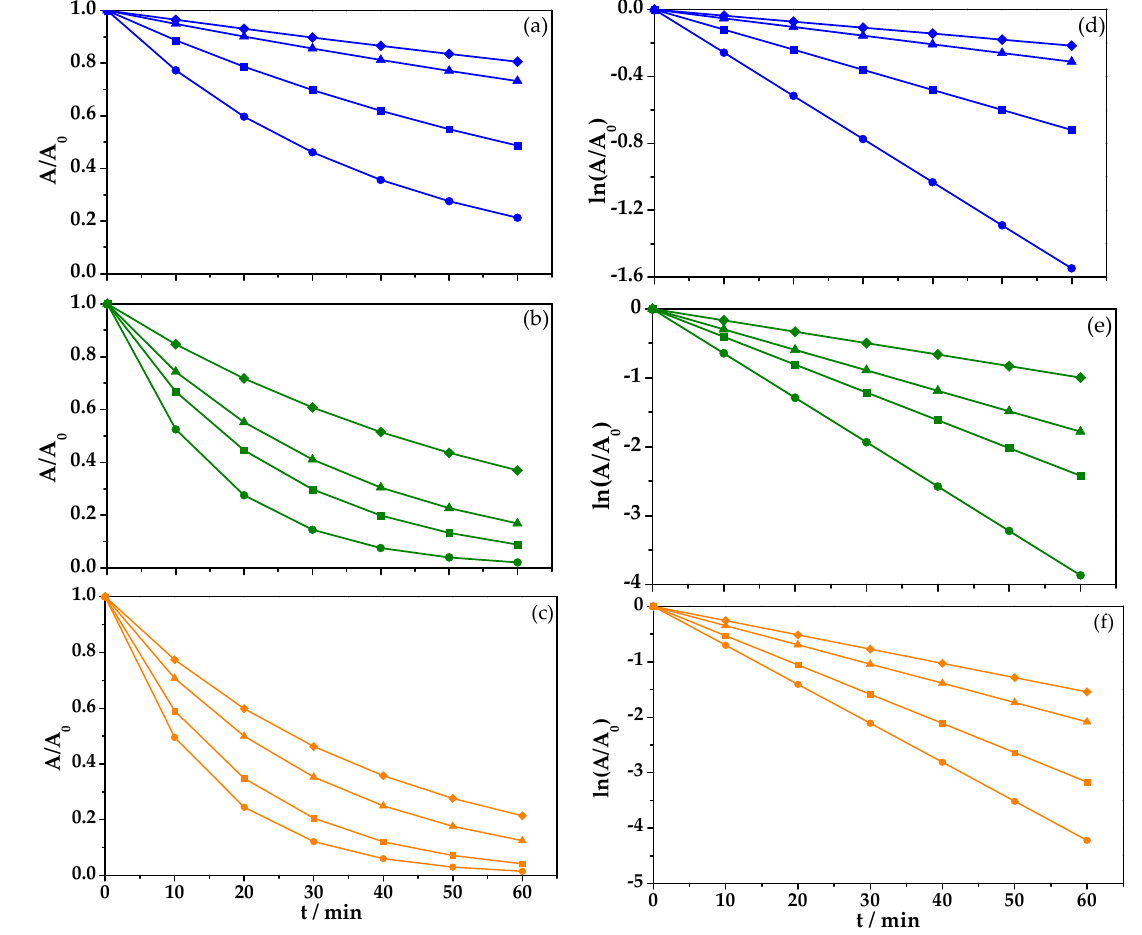
Figure 7. Removal of an aqueous solution of BBR azo dye, C 0 = 50 mg/L, during the oxidation process in 0.05 M of Na 2 SO 4 and at a pH of 3 with a solution volume of 0.1 L, ( a ) j = 7 mA cm − 2 , ( b ) j